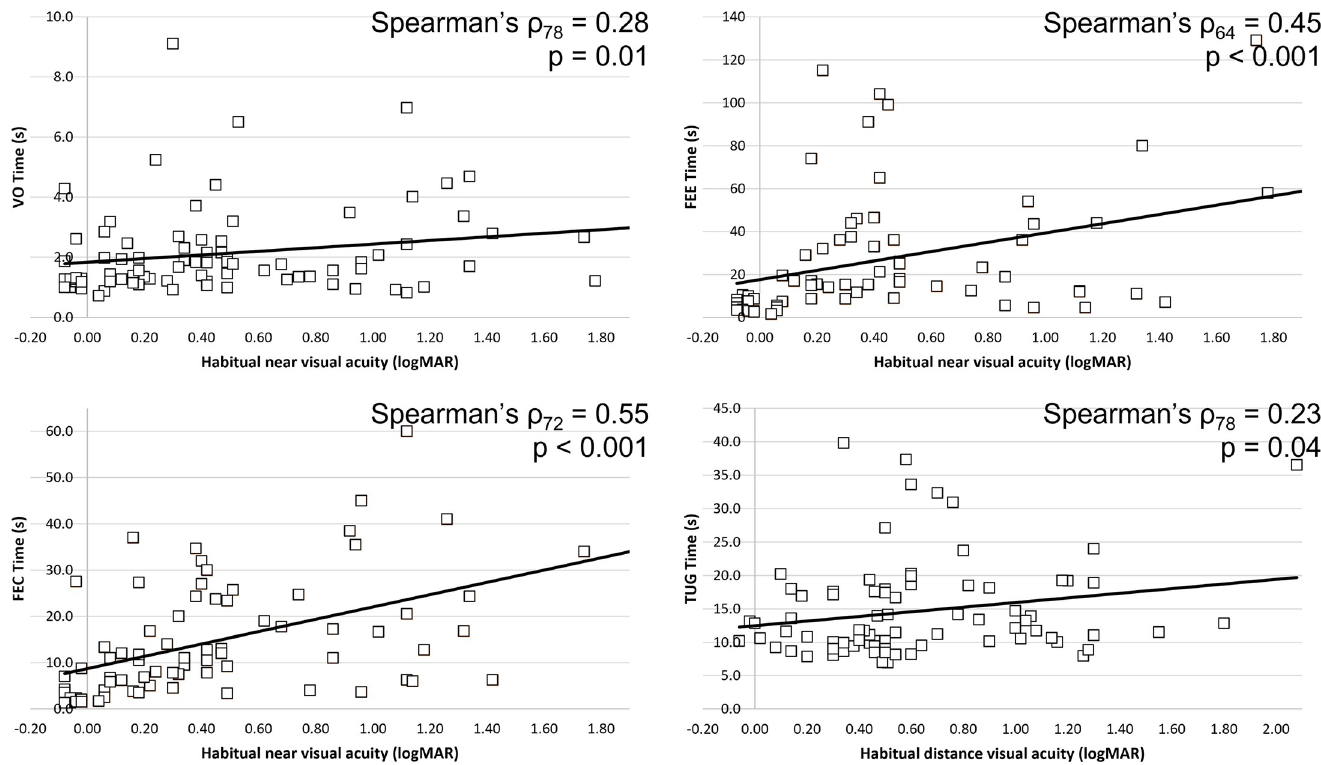
Fig 1. Relationship between visual acuity, visual processing functions (visual orientation (VO, N = 81), facial expression cards (FEC, N = 74), and facial expression examiner (FEE, N = 67), and dynamic balance function (time-up-go [TUG], N = 81). VO, FEC, and FEE were associated with habitual near acuity, while TUG was associated with habitual distance